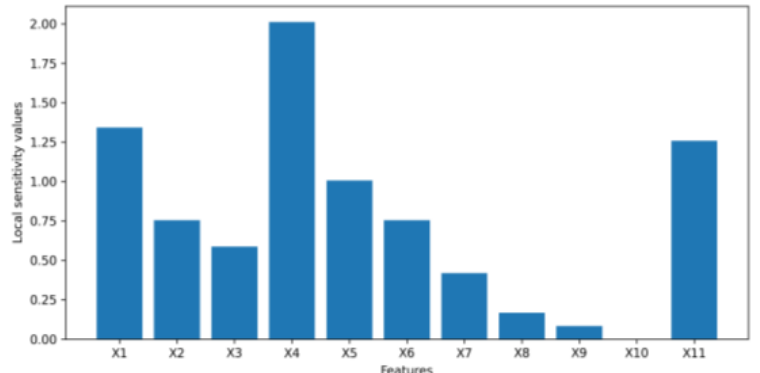
Figure 12. Global feature importance values for dataset 2.